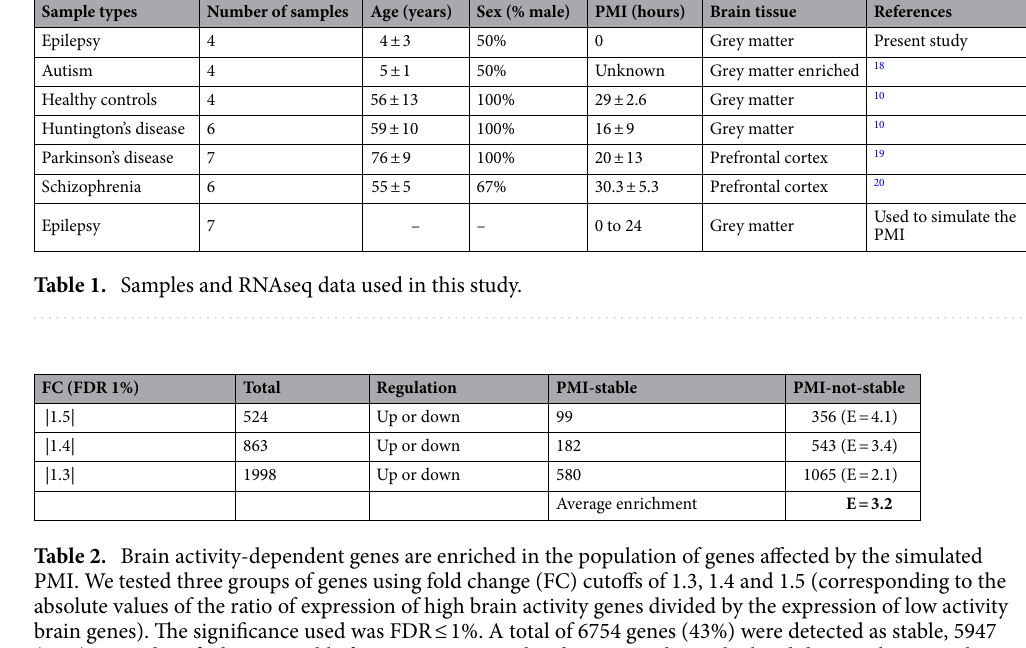
(Table 2). The threshold to detect activity-dependent genes was related to the probability of being affected by the PMI. The higher the relative expression of the brain activity gene, the more it was enriched in the popula- tion of genes affected by the PMI. These findings confirm that genes involved in brain activity are more prone to degradation during the PMI. One possible explanation for the selective loss of activity-dependent genes could relate to the stability of various cell populations during the simulated PMI. As a means to implicate specific cell populations that could be responsible for the reduction of genes during the simulated PMI we used a clustering algorithm as we have previously described 9 . We found that 1427 genes (71% known brain activity-dependent genes) could be clustered across the seven time points of the simulated PMI. For these clusters, we used AllegroMcode to identify two main clusters. One cluster of 317 rapidly declining genes was predicted to be neuronal and strongly overlapped with the activity-dependent genes. A second cluster of 474 genes was predicted to be glial, including astrocytes and microglia (Fig. 3A). Remarkably, as the neuronal cell cluster rapidly fell, there was a reciprocal and dra- matic increase in the expression of the glial cell cluster (Fig. 3B). PCA on all 7 time points of the simulated PMI using the 500 most downregulated activity-dependent genes in postmortem samples revealed the same type of separation from the time point 0H to the latest time point 24H (Fig. 3C). Gene ontology analysis of the genes composing the two main clusters using the whole human genome as reference indicate mostly phagosome based pathways for glia cells while synapses appear to be the most significant pathway in the neuronal cell (Table 3). Most studies assess RNA stability using a combination of RNA electrophoresis and housekeeping gene stabil- ity. Surprisingly, RNA stability at each time point showed no degradation except for a slight decrease of RNA quality at time point 1H and 4H using the commonly used RIN numbers and total RNA electrophoresis (Fig. 3D). The slight decrease of RNA integrity at time points 1H and 4H could explain the non-linearity of results observed at these two time points specially visible in the glia profile. We further examined the expression of 64 reference genes (‘housekeeping’ genes) commonly used in human genomic experiments for normalization across the simulated PMI (Supplemental_Table_S2.xlsx). From these 64 reference genes, only four were not stable, 48 (75%) were part of 6754 genes that were highly stable from 0 to 24 H, and 57 (89%) were stable until 12H. This corresponds to a ~ tenfold enrichment of housekeeping reference genes among the genes that were stable across the simulated PMI. In addition to performing RNAseq, at each time point a portion of each tissue sample was immediately placed in 4% paraformaldehyde for histological examination. We stained each block of tissue with H&E as well as specific markers for neurons (NeuN), microglia (CD68) and astrocytes (GFAP) and reviewed these with our neuropathologist (TVN) (Fig. 4). At 2 h, we observed a decrease of nuclear staining for NeuN and neuronal swell- ing. Between 4–8 h a majority of the neurons were swollen with a marked reduction in nuclear NeuN staining and by 12 h the neurons demonstrated loss of nuclear detail on H&E and NeuN staining was markedly reduced. At 24 h staining by NeuN showed that a majority of neurons were degraded. In contrast, between 2–4 h microglia became activated with increased process outgrowth peaking at 12 h. In parallel, astrocytes stained with GFAP